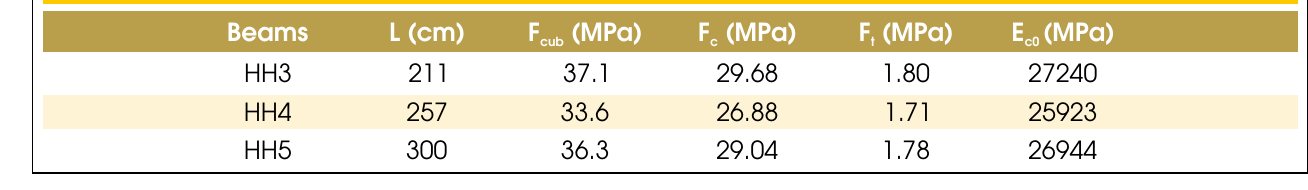
Table 2 – Mechanical properties of concrete